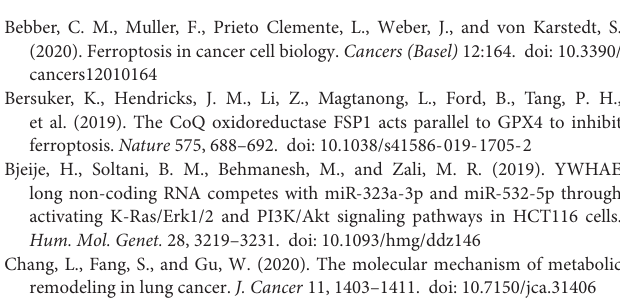
Supplementary Table 1 | Genes of drivers, suppressors, and markers of ferroptosis. Supplementary Table 2 | 259 genes were identified as the ferroptosis-related genes. Supplementary Table 3 | 222 autophagy-associated genes identified from the Human Autophagy Database. Supplementary Table 4 | 4138 genes were significantly predicting the prognosis of LUAD patients by both Kaplan-Meier and univariate Cox regression analyses ( P -value < 0.05). Supplementary Table 5 | The correlations of 222 autophagy-related genes with the fifteen-gene signature risk score examined by the Pearson correlation coefficient.